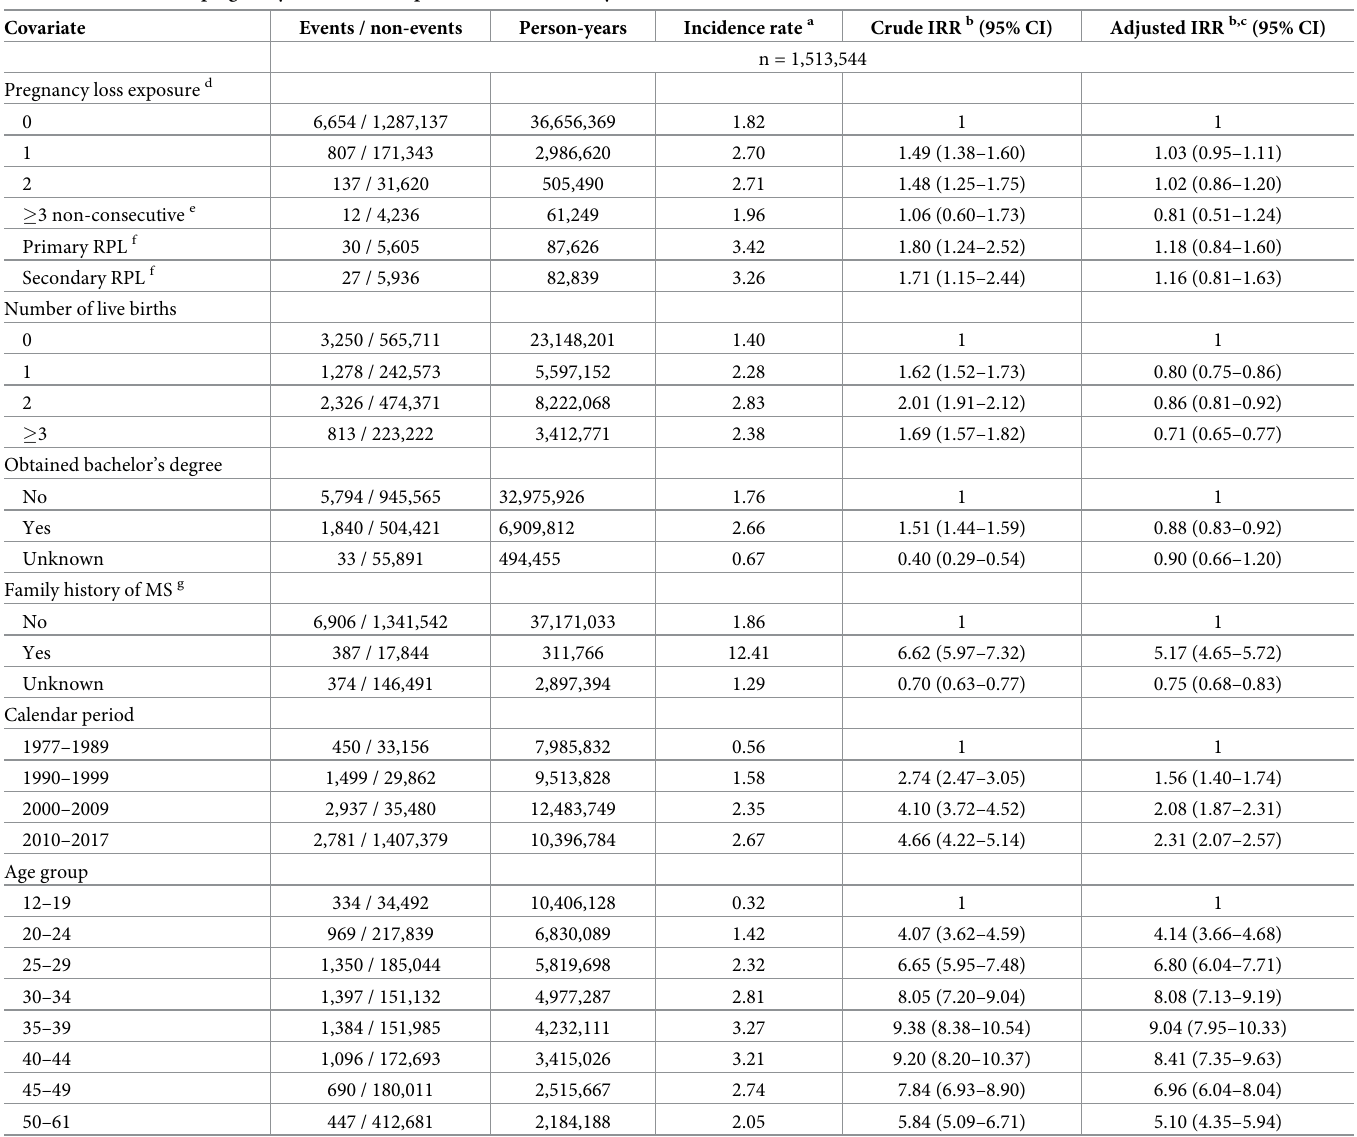
Table 1. Association of pregnancy loss with multiple sclerosis, main